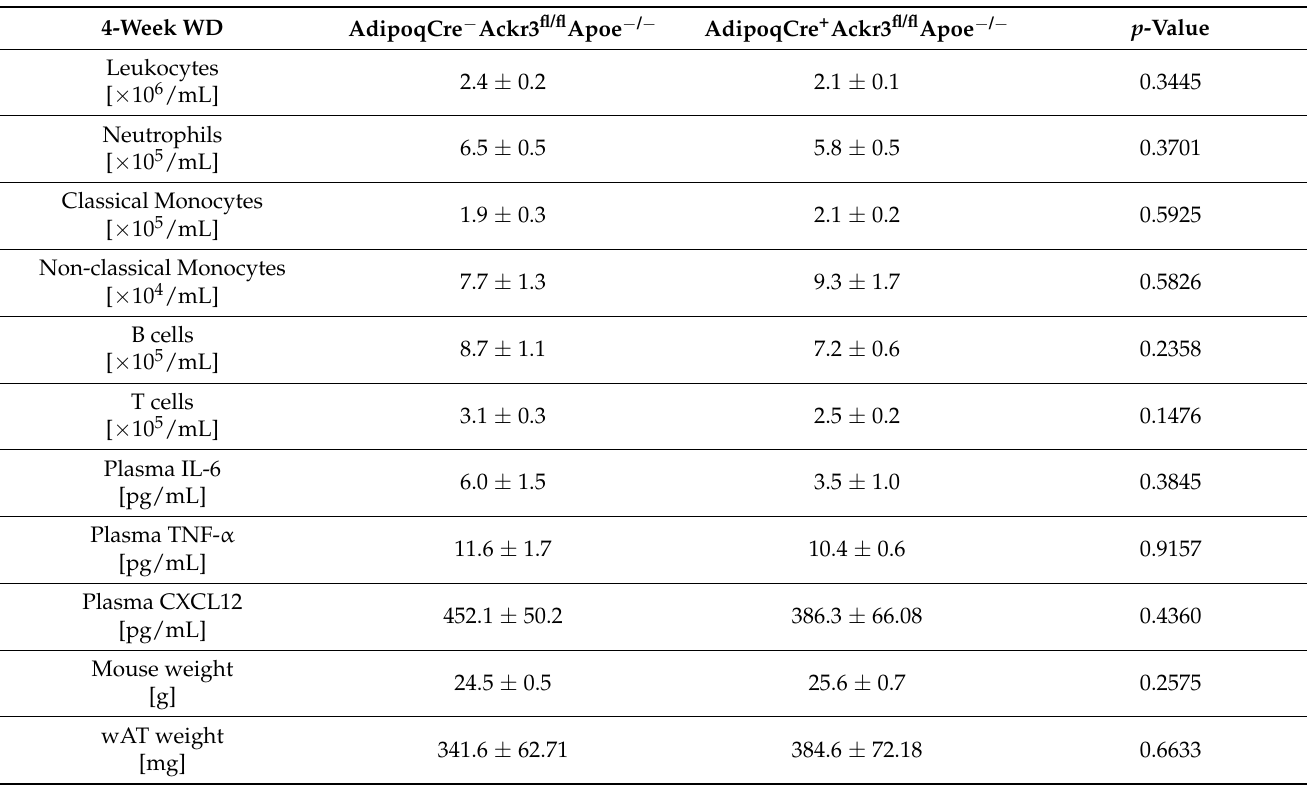
Table 1. Quantification of circulating immune cells, plasma cytokines, mouse, and wAT